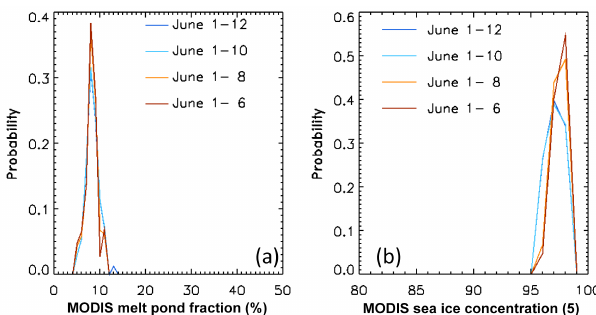
Figure 2. Histograms of MODIS melt-pond fraction (a) and MODIS sea-ice concentration (b) derived when sea-ice cover was near 100% and melt ponds were not yet present (see text for details) for the first 7, 9, 11, and 13 days of June